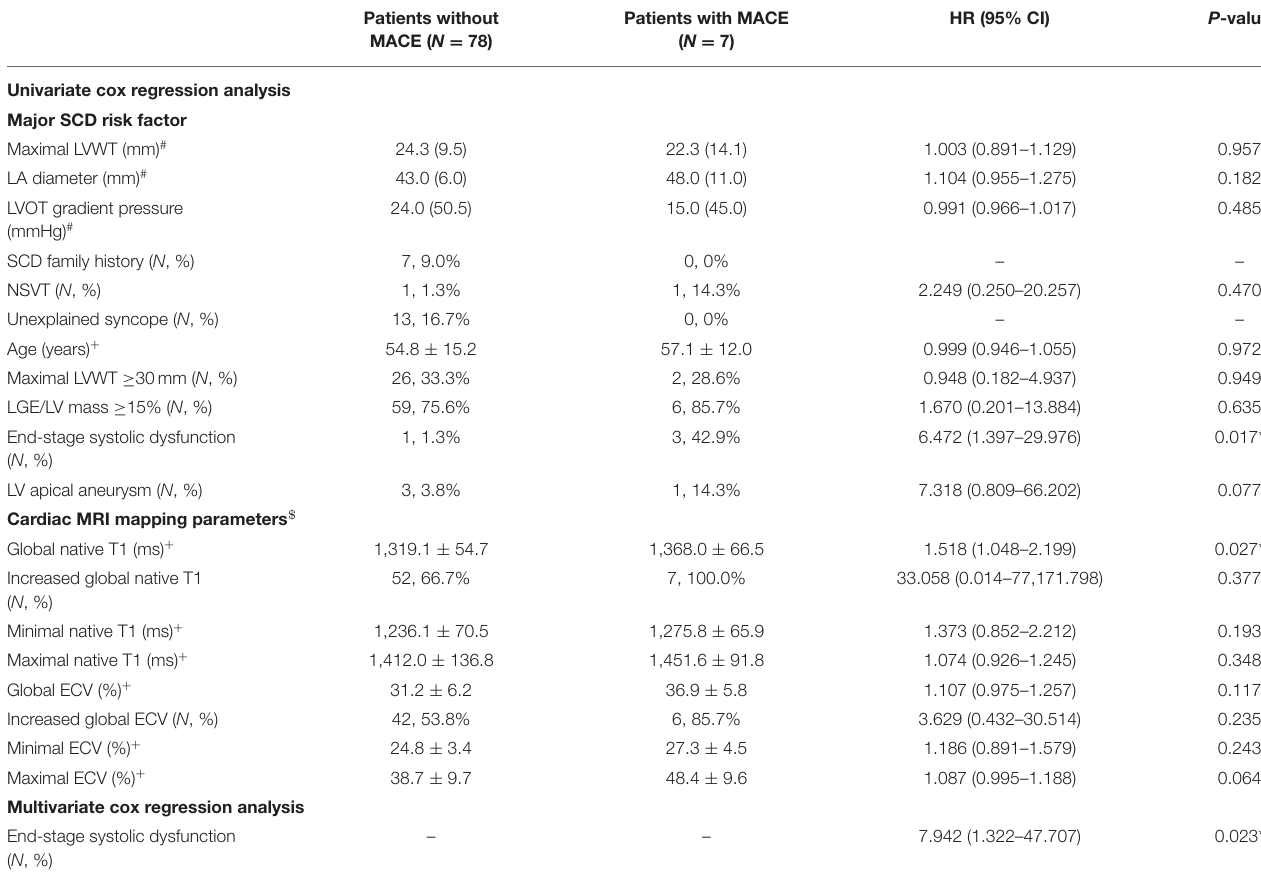
TABLE 7 | Univariate and multivariate Cox regression analysis of T1 mapping values for the prediction of MACE in subgroup 2.